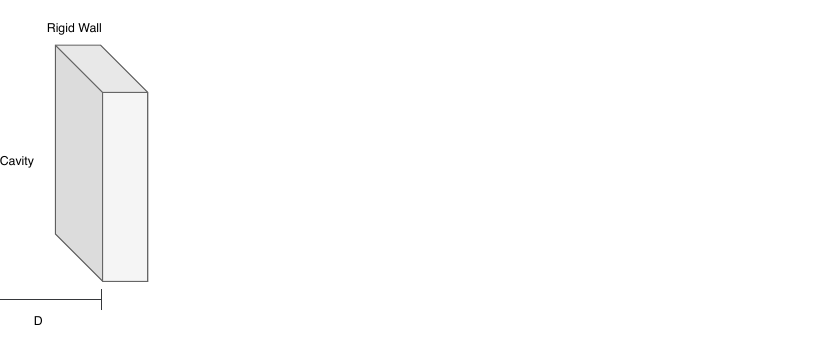
Figure 1. Schematic representation of a single-layer micro-perforated panel (MPP) and its dimen- sional